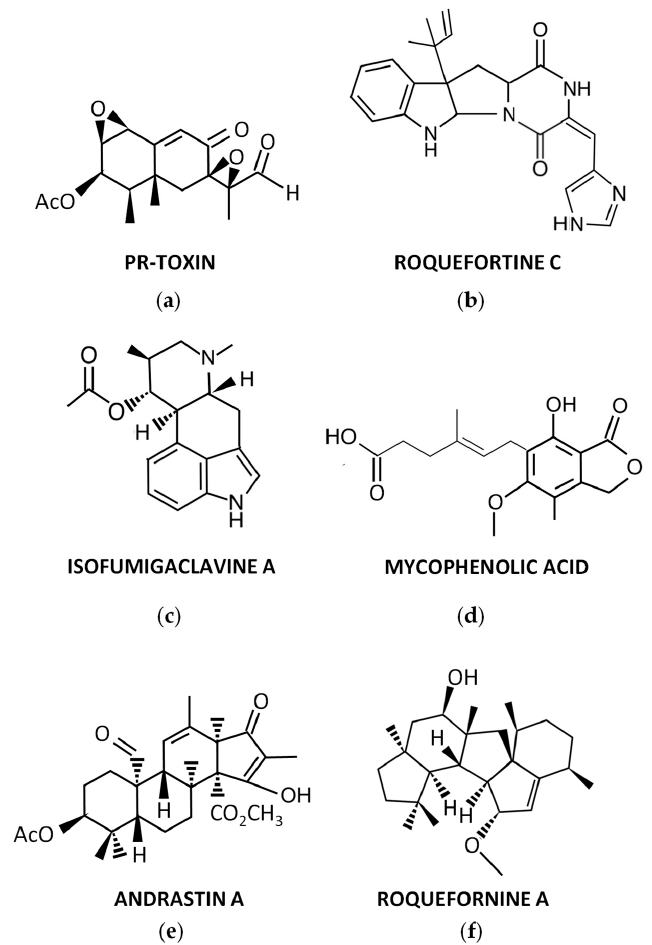
Figure 1. Representative secondary metabolites produced by P. roqueforti : ( a ) PR-toxin; ( b ) Roquefortine C; ( c ) Isofumigaclavine A; ( d ) Mycophenolic acid; ( e ) Andrastin A; ( f ) Roquefornine A.